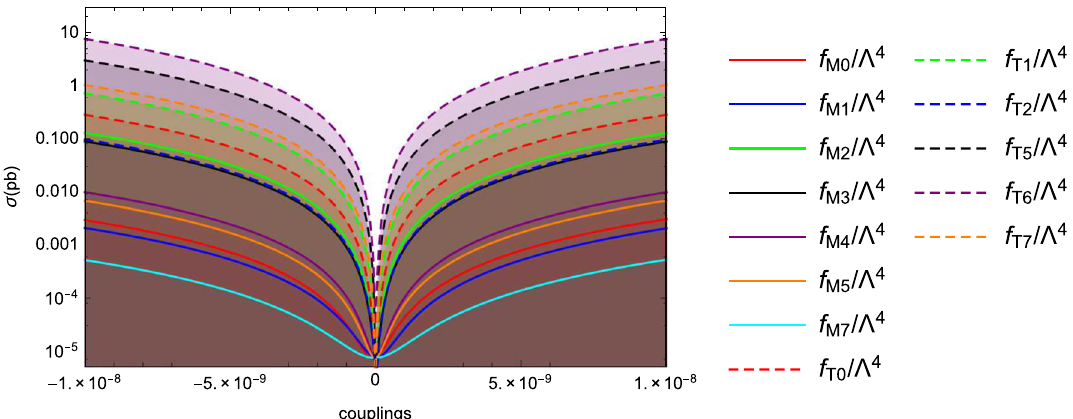
Fig. 3 For leptonic channel, the total cross-sections of the process e − p → e − γ ∗ p → pW − γν e as a function of the anomalous couplings at the √ s = 1 . 30 TeV LHeC with